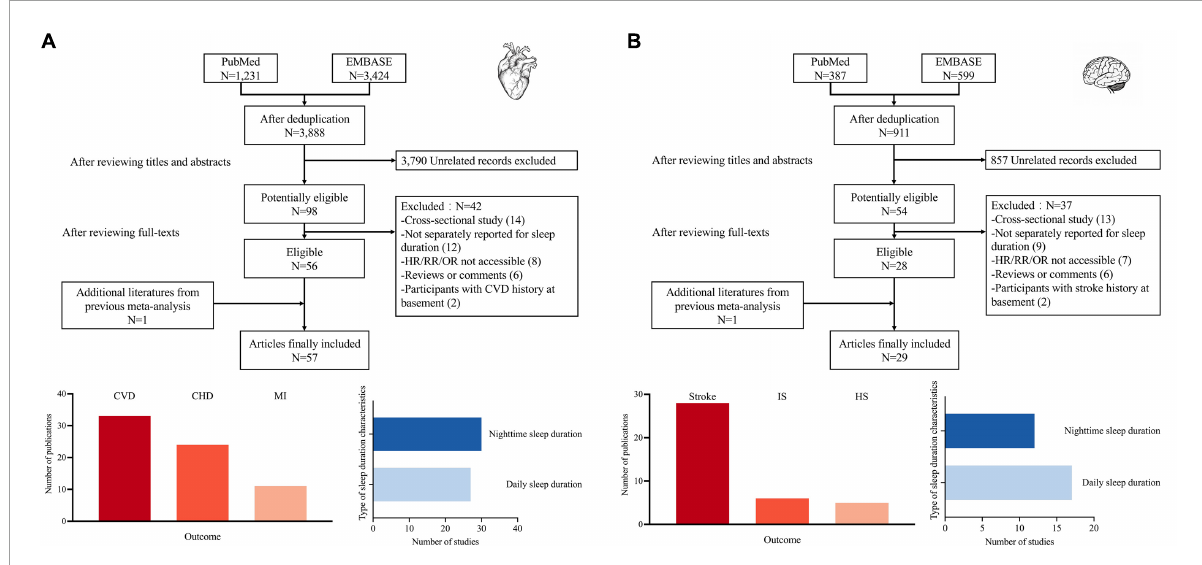
FIGURE1 Search flowchart and summary characteristics of included studies, (A) for cardiovascular diseases and (B) for cerebrovascular diseases. CVD, cardiovascular disease; CHD, coronary heart disease; MI, myocardial infarction; IS, ischemic stroke; HS, hemorrhage stroke.